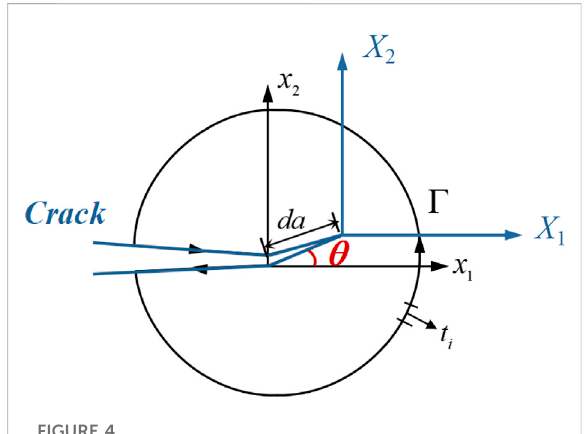
FIGURE 4 Crack-tip pro fi le diagram of a de fl ective